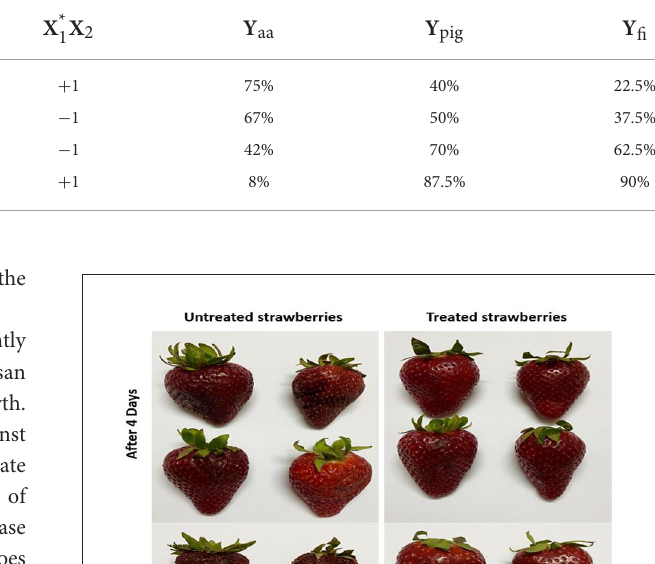
TABLE 3 Results of the experimental design applied in the post-harvest treatment of strawberries. X 1 X 2 X *